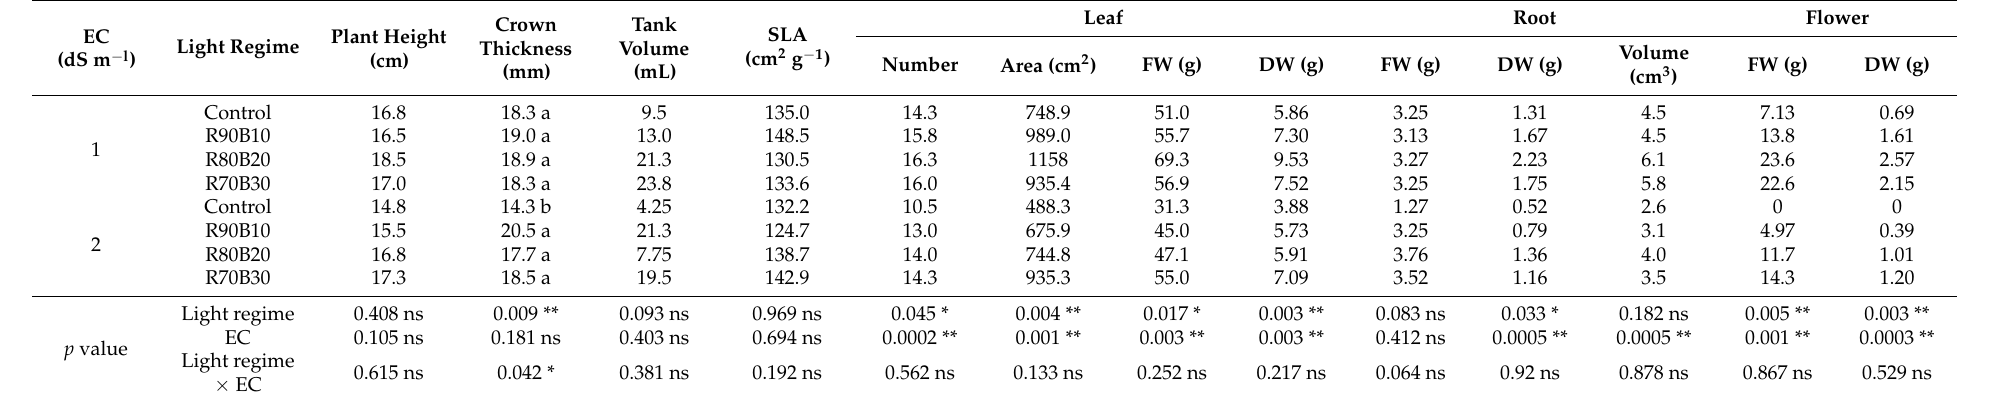
Table 4. Effect of supplementary light and nutrient solution electrical conductivity (EC) on growth and morphology of Vriesea ‘Splenriet’ plants. The light treatment included control (no supplementary light), R90B10 [90% red (R) and 10% blue (B)], R80B20 (80% R and 20% B), and R70B30 (70% R and 30% B), while the EC values employed were 1 and 2 dS m − l .